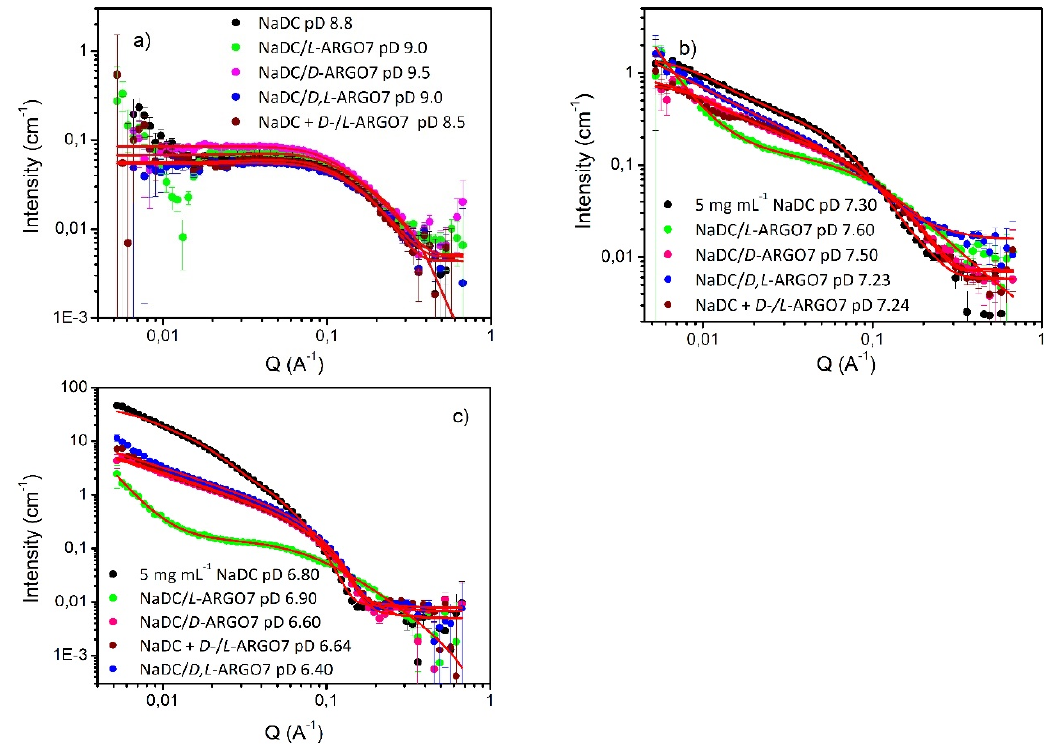
Figure 3. 5 mg mL − 1 NaDC scattering data in presence of 0.5 mg mL − 1 D -, L -, D,L -ARGO7 and the equimolar mixture D - / L -ARGO7 at ( a ) pD 9.5 – 8.5; ( b ) pD 7.23 – 7.60; and ( c ) pD 6.40 – 6.90. Fittings are reported as red lines.